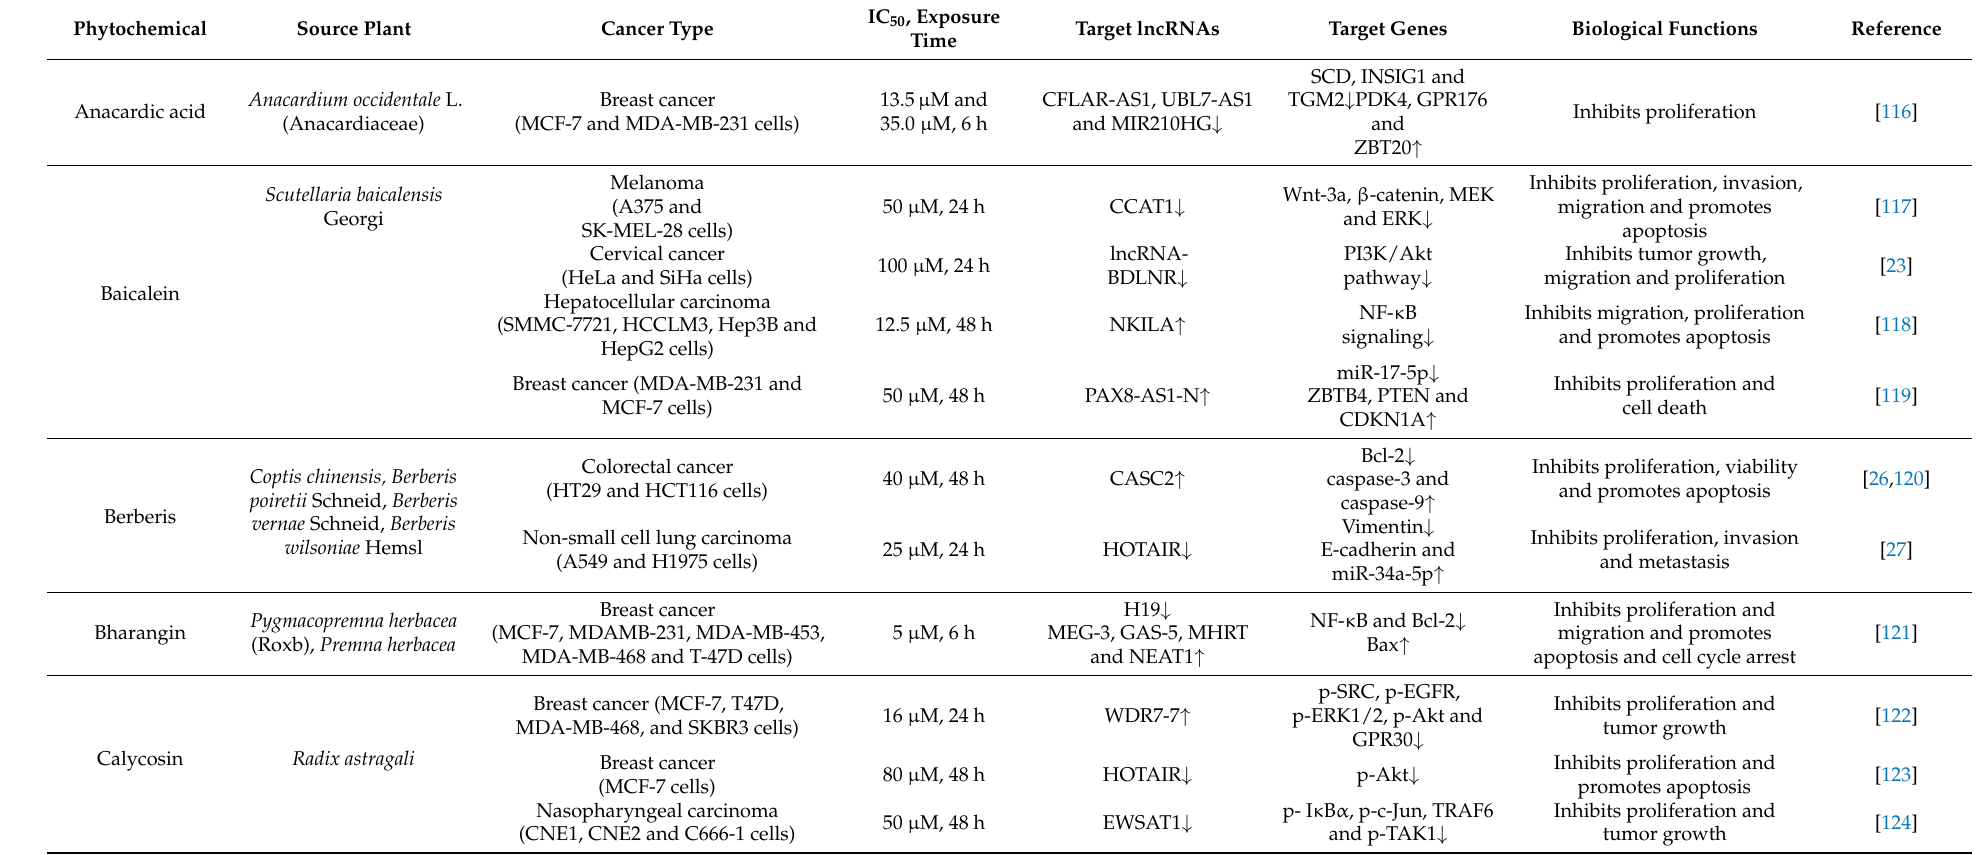
Table 2. Anticancer therapeutic effects of phytochemicals by regulation of lncRNAs and their target genes in various in vitro cancer